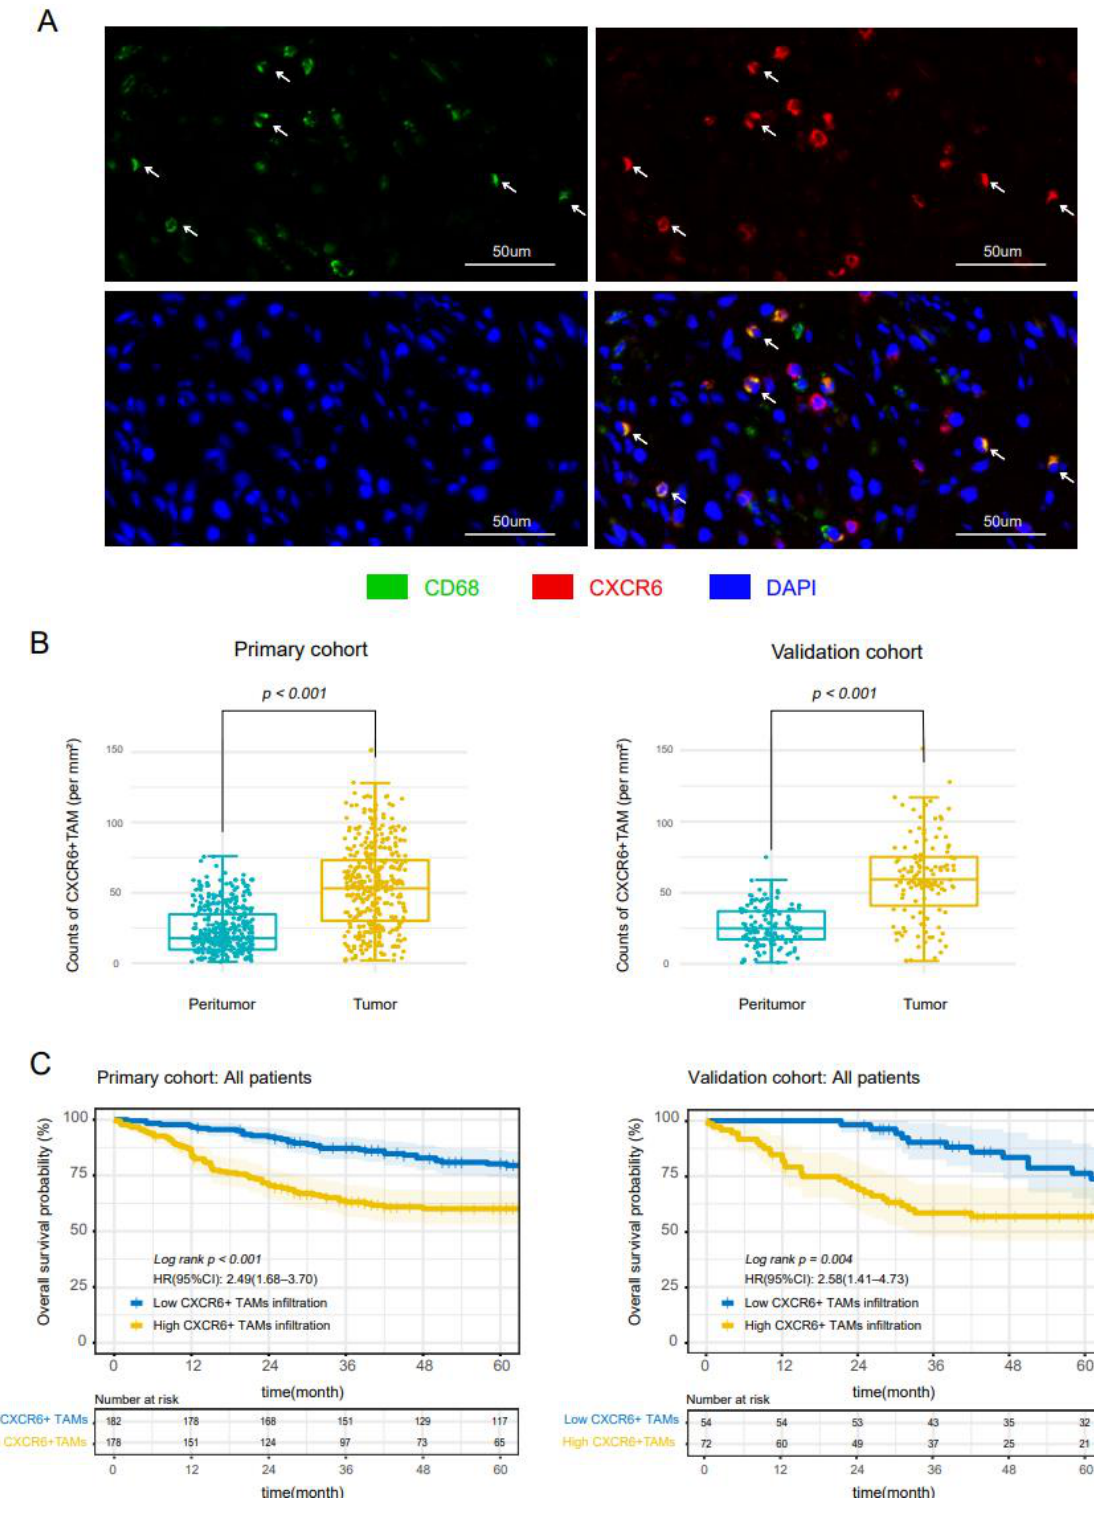
Figure 1. CXCR6+ TAMs are infiltrated in CC and predict poor prognosis in all patient stages. ( A ) Figure 1. CXCR6+TAMs are infiltrated in CC and predict poor prognosis in all patient stages. Representative images of CXCR6+ TAMs in CC specimens. White arrows indicate CXCR6+ TAMs. ( A ) Representative images of CXCR6+TAMs in CC specimens. White arrows indicate CXCR6+TAMs. ( B ) Statistical analysis of the density of CXCR6+ TAMs in tumor tissues and peritumor tissues in ( B ) Statistical analysis of the density of CXCR6+TAMs in tumor tissues and peritumor tissues in two independent cohorts. ( C ) Overall survival curves of all patients with high and low CXCR6+TAM infiltration in two independent